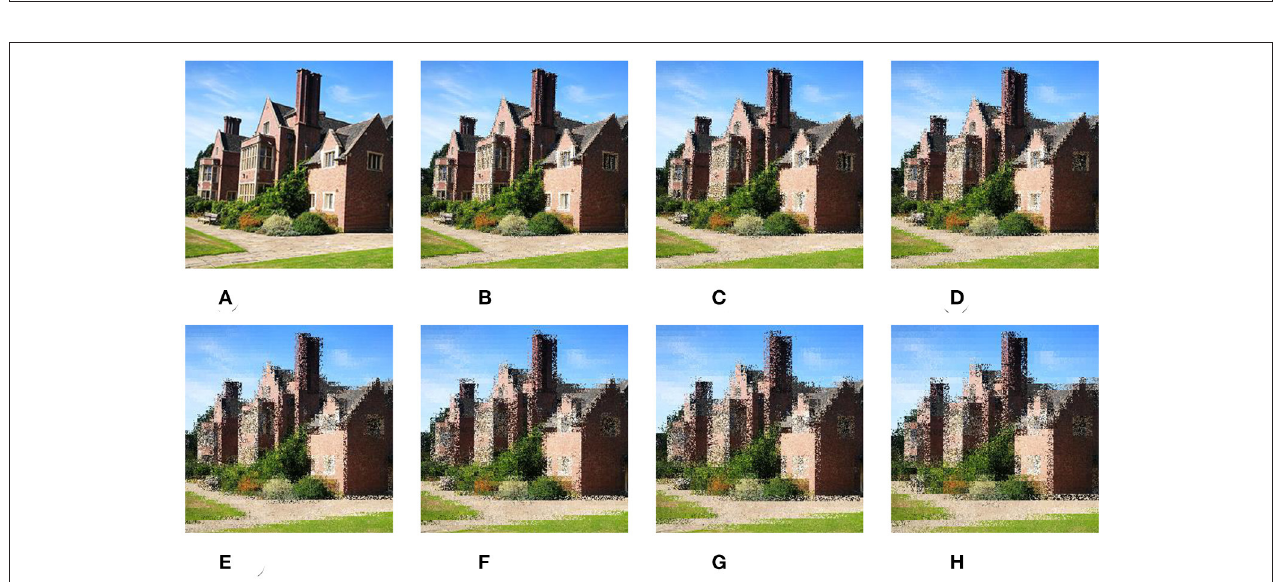
FIGURE 7 | Results of PatchShuffle (PS) on a grayscale image. (A) Raw image. (B) q = 2. (C) q = 3. (D) q = 4. (E) q = 5. (F) q = 6. (G) q = 7. (H) q = 8.